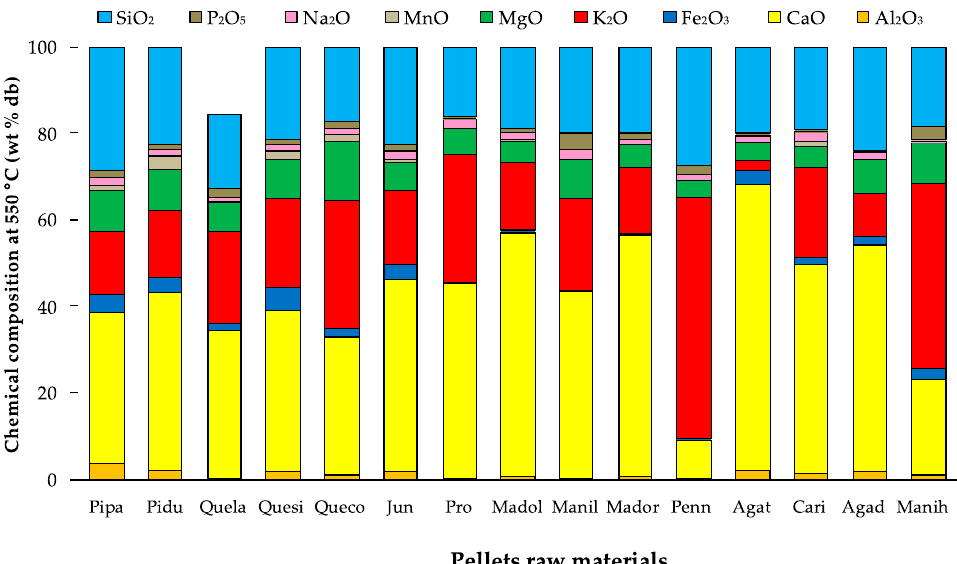
Figure 2. Chemical composition (wt % db) of majority elements of pellet ash from 15 sources calcined at 550 °C.